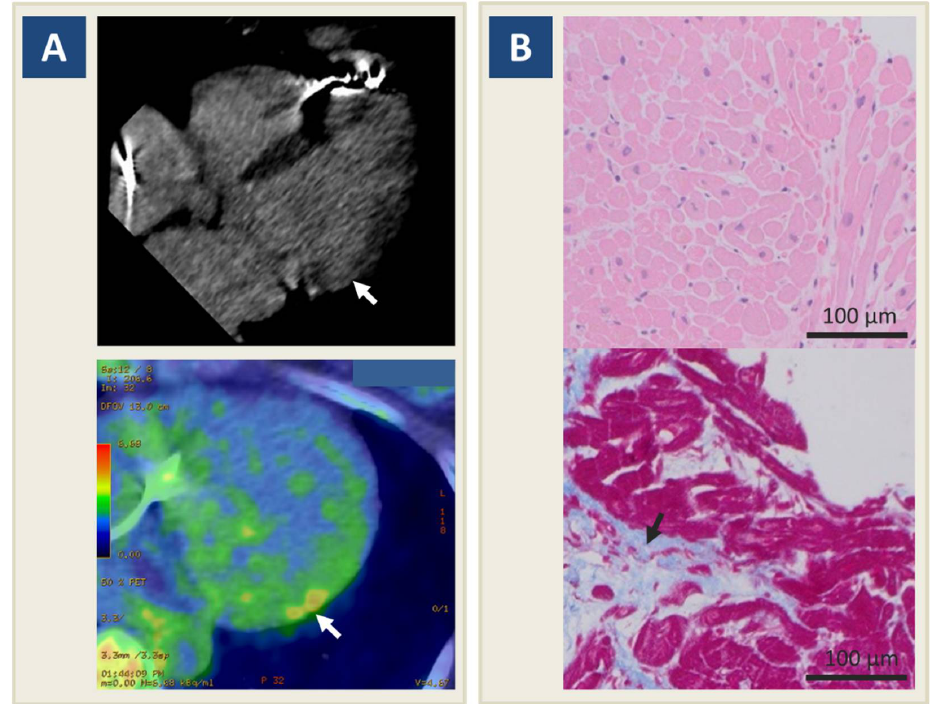
Figure 3. Follow-up restaging of myocarditis. Legend. ( A ) Cardiac computed tomography shows subepicardial late iodine enhancement in the lateral left ventricular wall (upper panel, arrow), corresponding to baseline findings on cardiac magnetic resonance; at the same time, 18-F fluorodeoxyglucose positron emission tomography scan shows no remarkable myocardial inflammatory activity at the same site (lower panel, arrow). ( B ) Follow-up endomyocardial biopsy shows rare lymphocytic inflammatory cells (CD3+ < 7 mm 2 ), lack of edema and no cardiac myocyte necrosis (upper panel); fibrosis is the dominant component (lower panel, arrow).